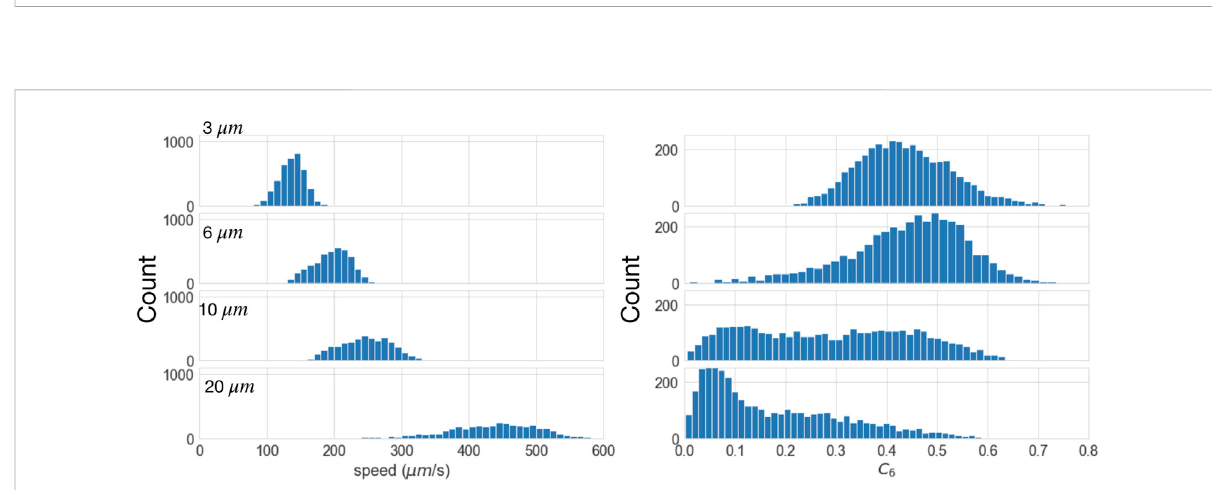
FIGURE 7 Histograms of speed and order generated from kymographs at applied stress 20 Pa (Each height: 3,900 kymographs, 65 ms each).